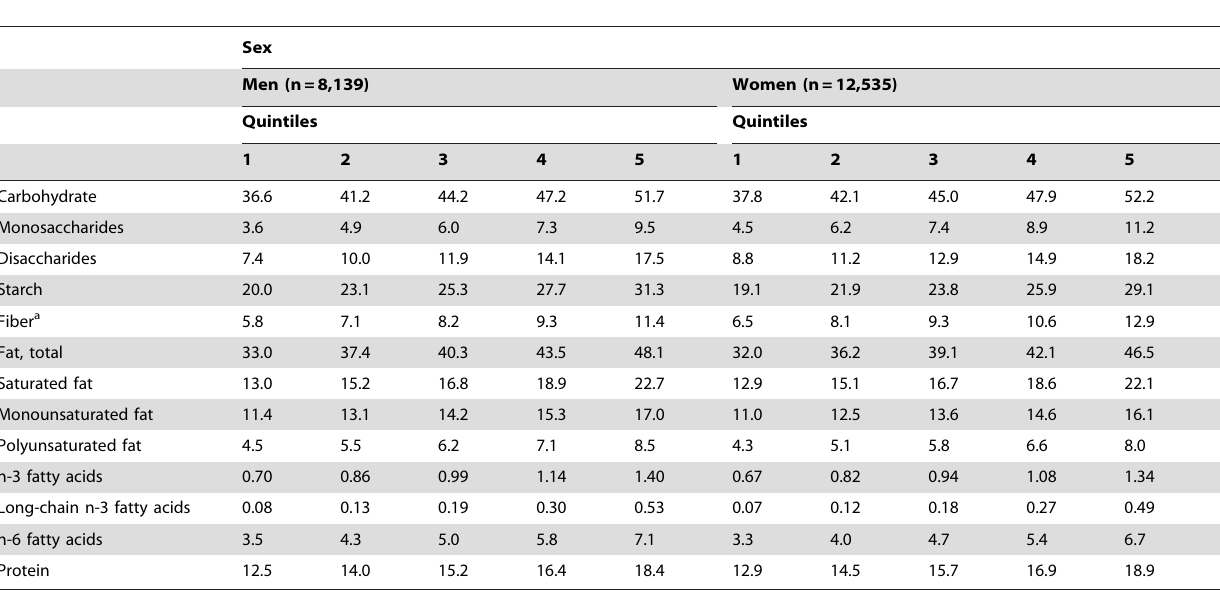
Table 2. Distribution of non-alcohol energy percentages from selected nutrients in participants of the Malmo¨ Diet and Cancer cohort with stable dietary habits